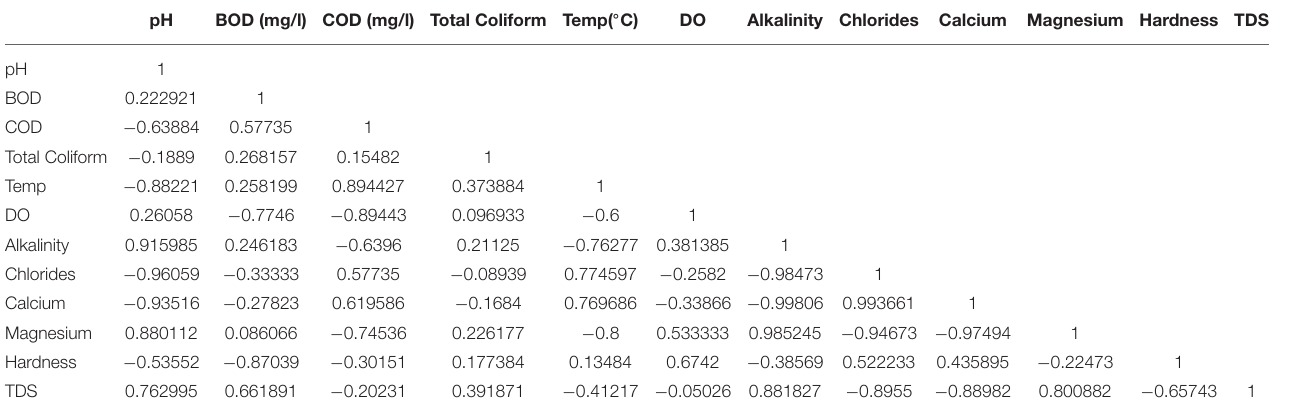
TABLE 5 | Correlation table for physicochemical parameters at Dehradun for